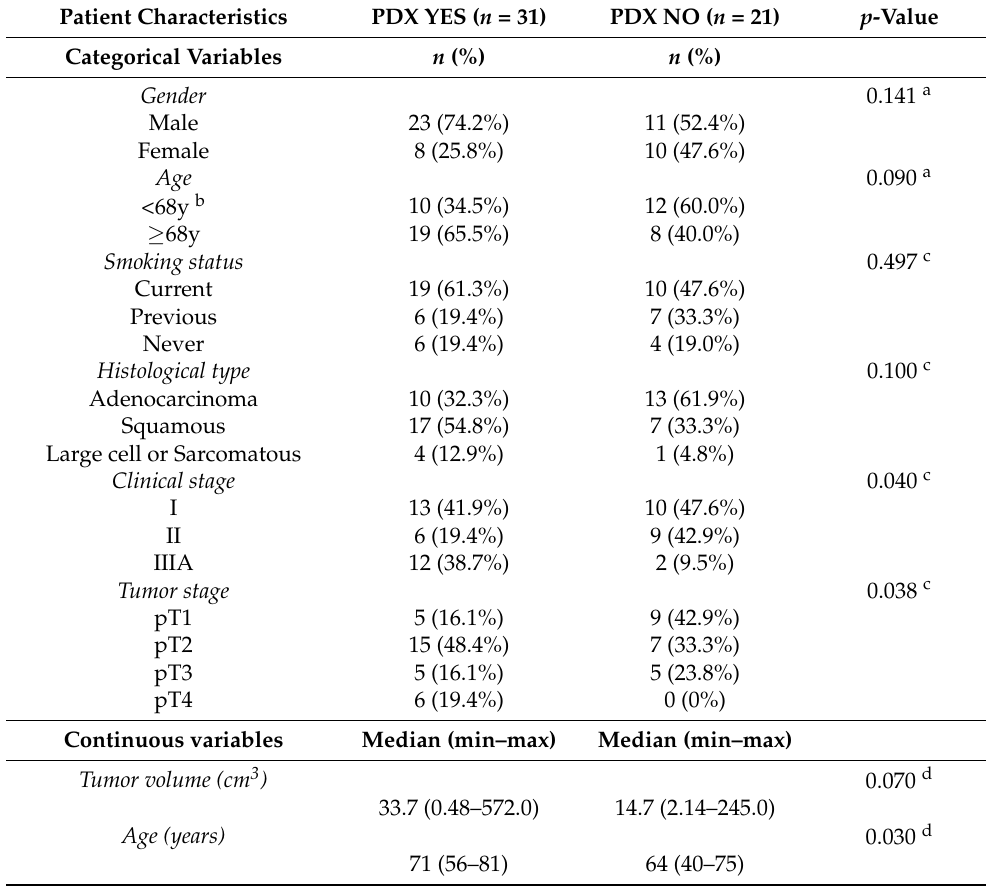
Table 1. Clinical and pathological characteristics of the